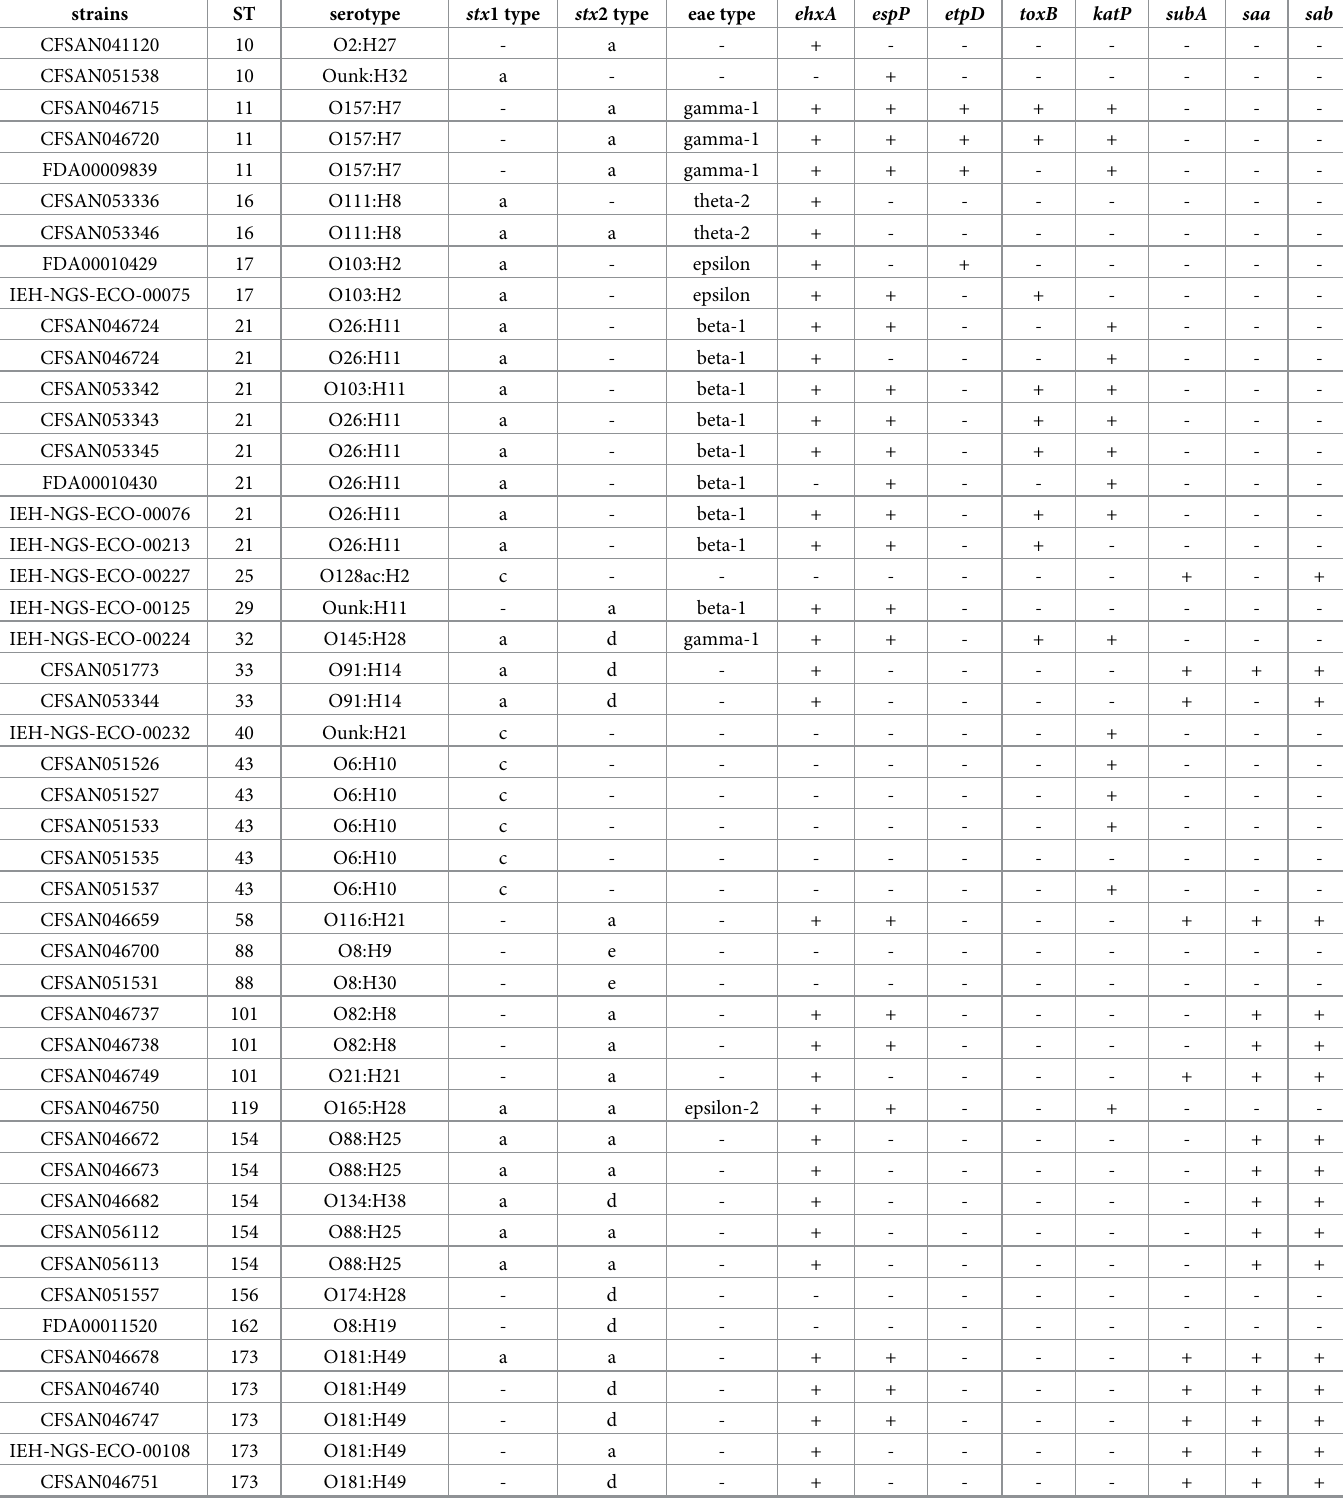
Table 4. in silico characterization of STECs from this study for presence of virulence genes and their serotype. strains